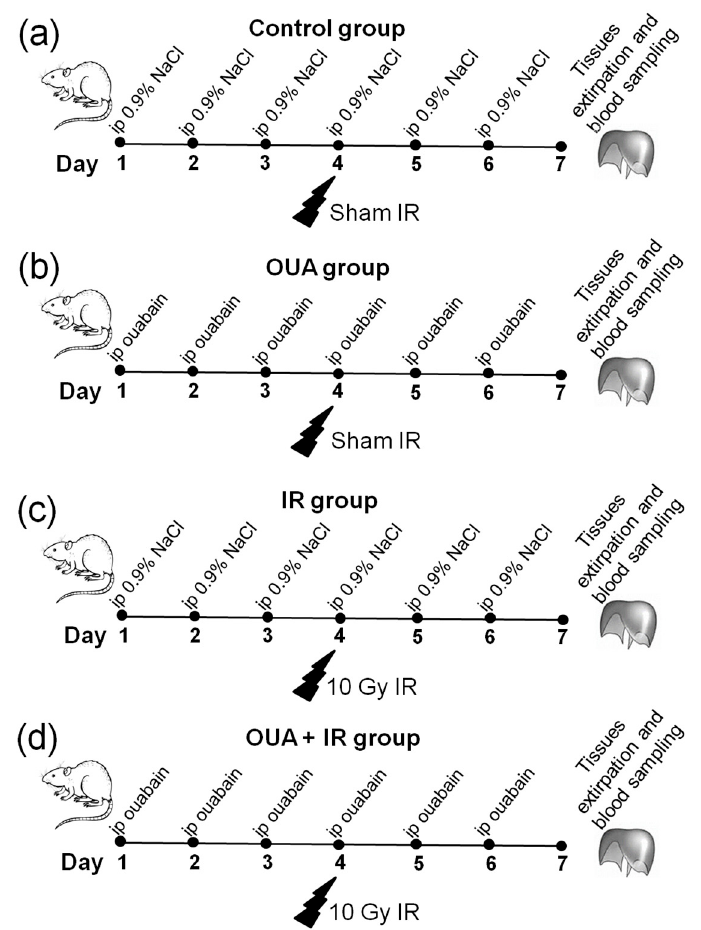
Figure 1. The study outline. ( a – d ) Rats were randomly divided into two groups and subjected to daily intraperitoneal (i.p.) injections of either 1 mL sterile 0.9% NaCl (vehicle)—( a , c ), or ouabain (1 µg/kg body weight) dissolved in 1 mL sterile 0.9% NaCl ( b , d ). On the fourth day of injections, rats in these two groups were randomly divided into rats exposed to irradiation procedure ( c , d ) and sham-treated rats ( a , b ). Thus, there were four experimental groups: rats subjected to i.p. injections of saline without exposure to irradiation—‘Control’ group ( a ); rats treated with ouabain without exposure to irradiation—‘OUA’ group ( b ); vehicle-injected rats exposed to total-body X-ray irradiation (10 Gy)—‘IR’ group ( c ); and rats treated with ouabain and exposed to irradiation—‘OUA + IR’ group ( d ). The diaphragm muscles and colon were dissected, and blood was collected 72 h after exposure to irradiation.